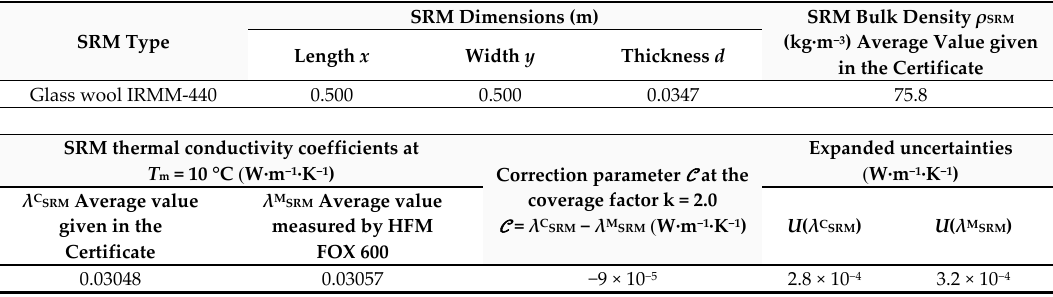
Table 1. Data concerning the Standard Reference Material (SRM) sample (size, bulk density, thermal conductivity, and the correction parameter).